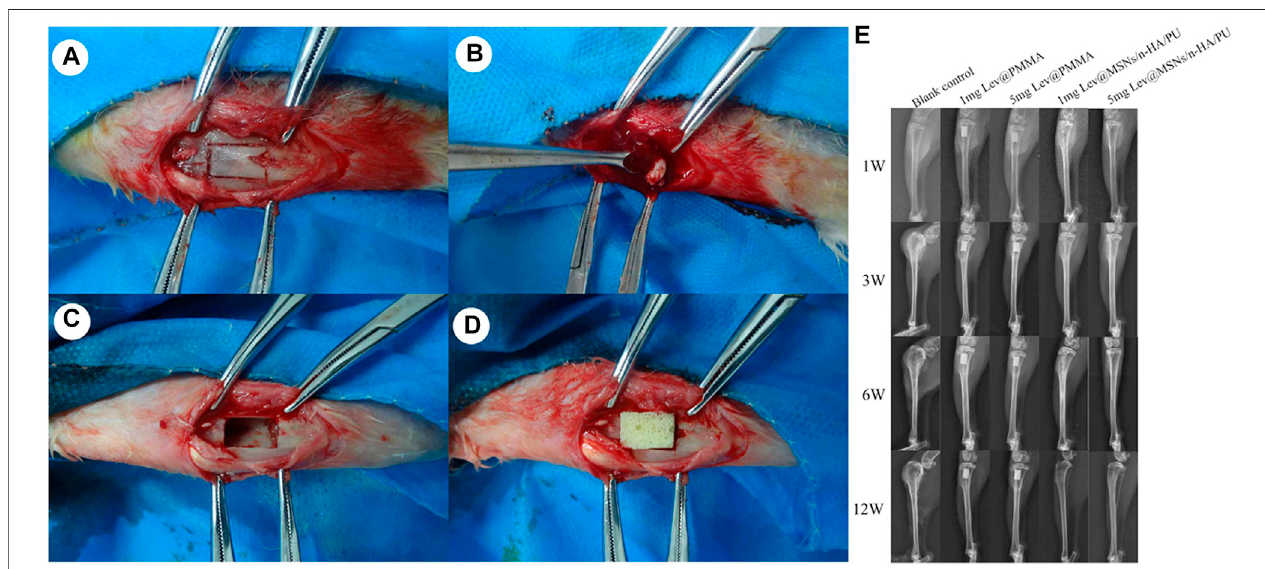
FIGURE 11 | The process of material implantation. (A) The cutting area was selected on the right side of proximal tibial; (B) Sequestrum, in fl ammatory tissue and purulence was debrided by using povidone iodine and normal saline; (C) After debridement, the size of the bone defects was 10 mm × 6 mm; (D) The new composite scaffolds was implanted in the bone defects; (E) Performance by X-ray imaging in each group at 3, 6, and 12 weeks, bone tissue swelling, decreased bone density, signi fi cant bone destruction, sequestrum formation, obscure boundary, osteolytic lesions, and cortical thinning were observed in the blank control group. No obvious osteomyelitis symptoms were observed in the 5 mg Lev@MSNs/n-HA/PU group. Reprinted from Wang et al. (2017). (Open